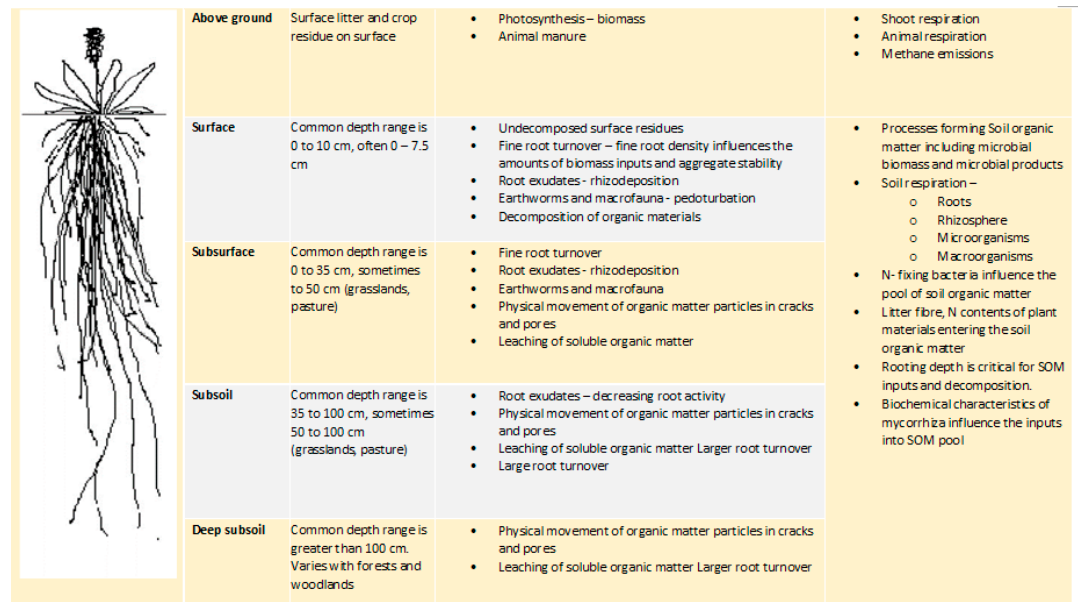
Figure 1. Zones for different processes changing with depth. [Adapted from 50,17,51].